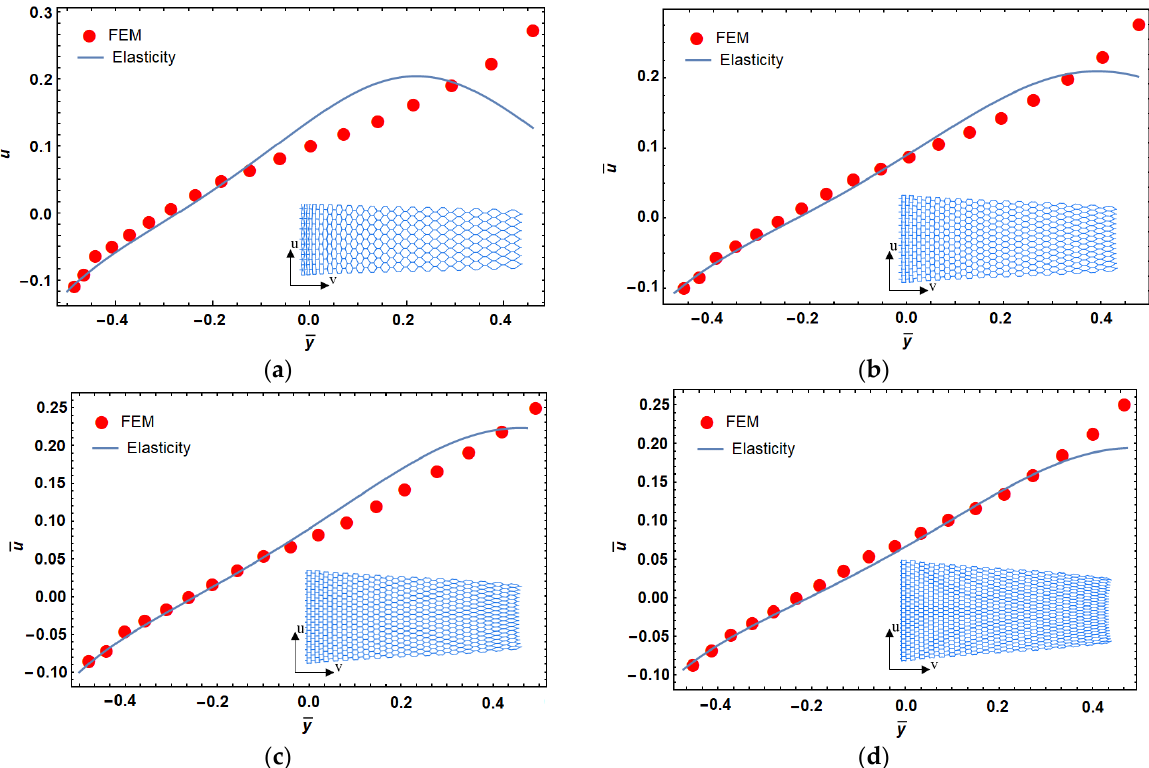
Figure 4. Porosity effect on dimensionless displacement in functionally graded reentrant structure; 94% ( a ), 92% ( b ), 90% ( c ), and 88% ( d ) porosity.